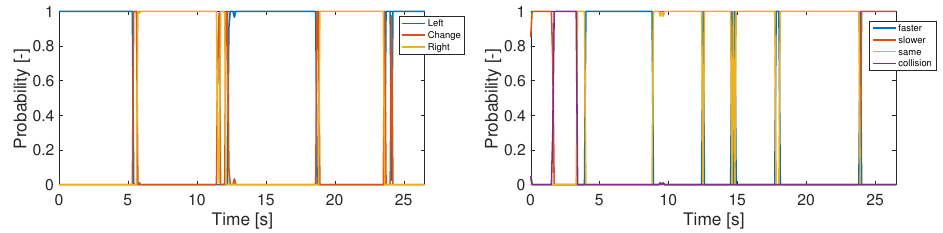
Figure 4. Probabilities of the investigated maneuvers using CTRA